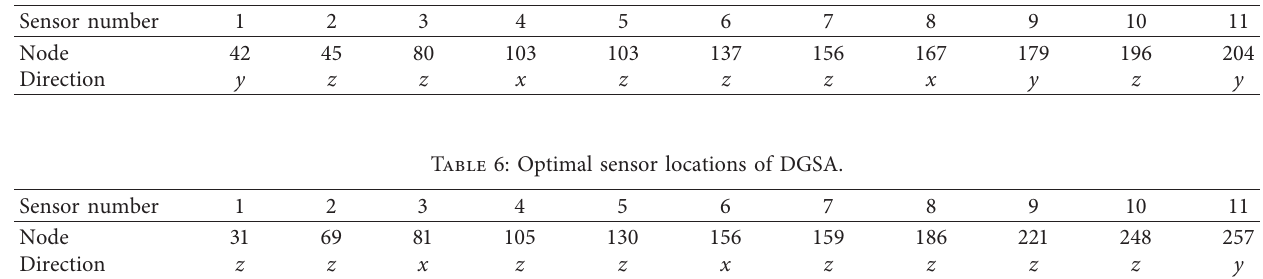
Table 5: Optimal sensor locations of